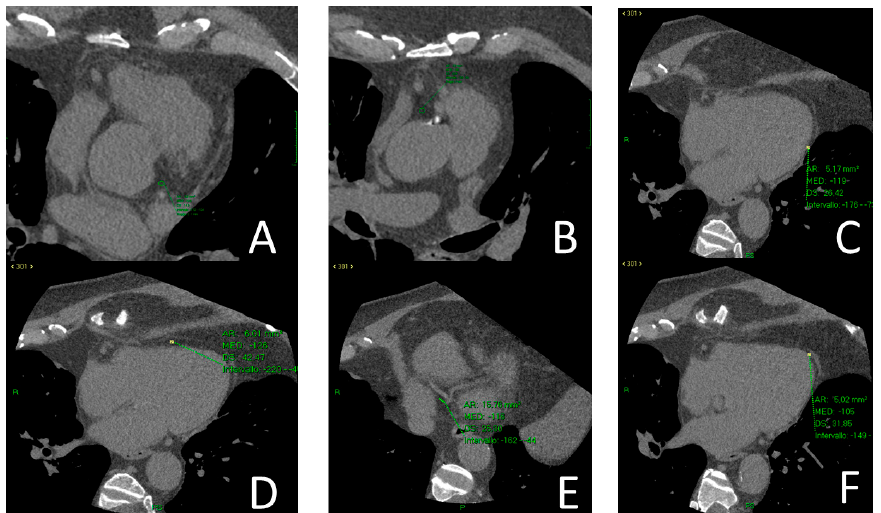
Figure 1. Epicardial Adipose Density measure using ROI at proximal left coronary artery ( A ), proximal right coronary artery ( B ), the lateral free wall of the left ventricle ( C ), the lateral free wall of the right ventricle ( D ), at the origin of the posterior interventricular artery ( D ), and at the level of the cardiac apex ( F ).